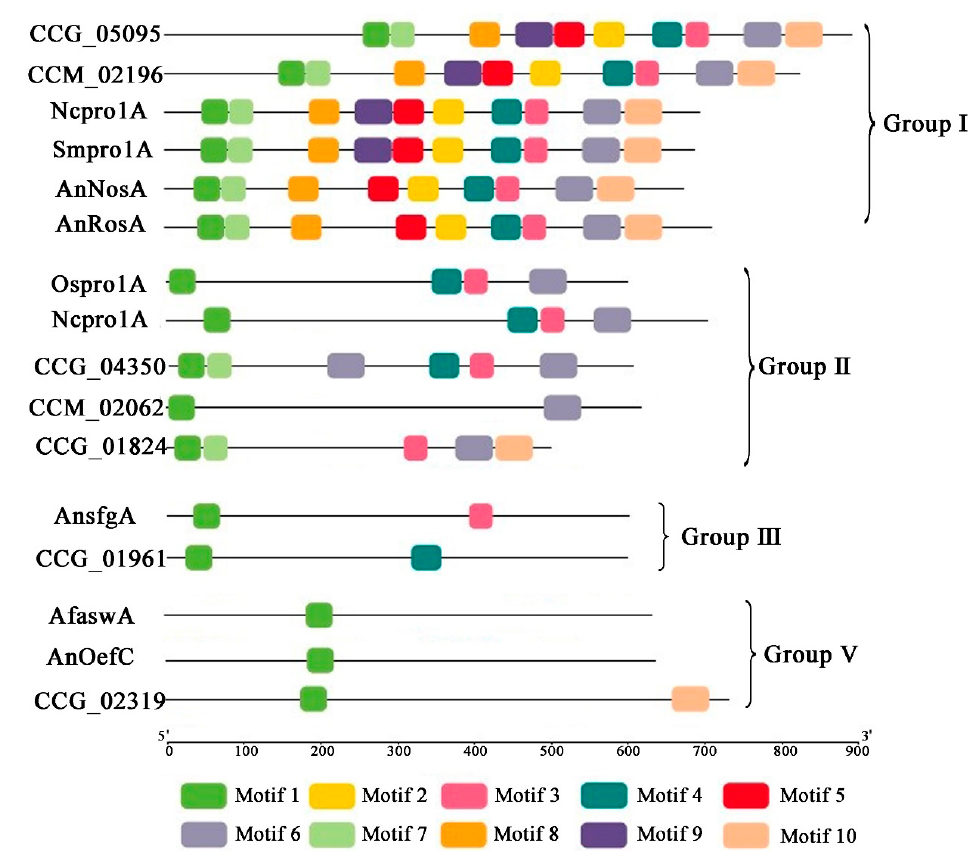
Figure 5. Conserved motifs in the DUF3468 domain contained C6 zinc proteins. Ten conserved motifs in all proteins were identified through the multiple EM for motif elicitation (MEME) analysis and were indicated in different colored boxes. CCG, T. guangdongense ; CCM, C. militaris ; Sm, S. macrospora ; Nc, N. crassa ; An, A. nidulans ; Os, O. sinensis ; Af, Aspergillus flavus . GenBank numbers of the related proteins are the same as Figure 4. Scale bar indicates a number of amino acids (aa). For details of motifs refer to Table S6 and Figure